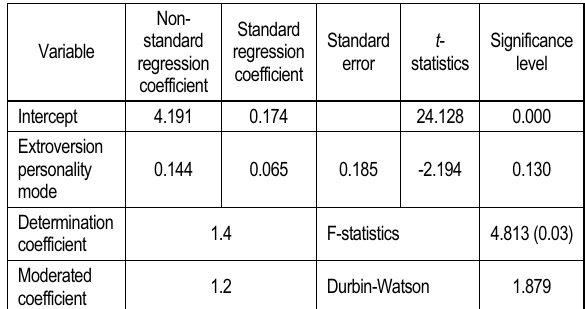
Table 4. Extroversion personality has a significant relation with career management of Melli Bank staff